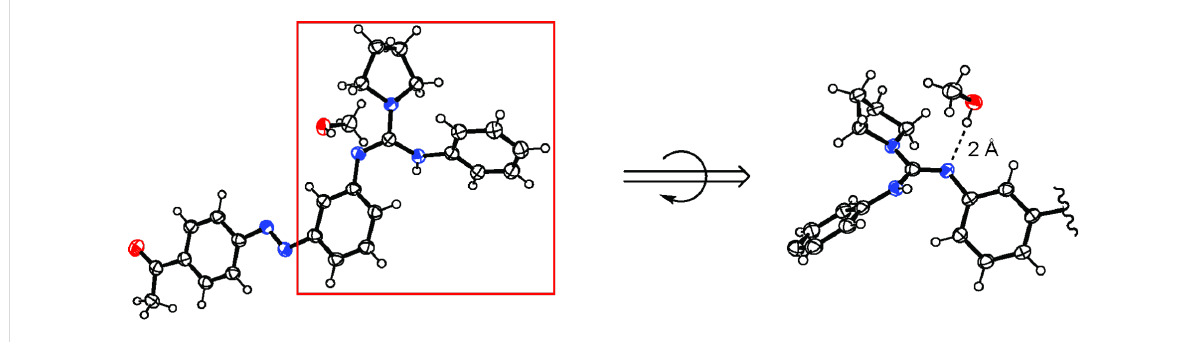
Figure 1: ORTEP image of the single-crystal X-ray structure of guanidine 2 E , as well as a rotated close-up of the guanidine moiety, showing 50% thermal ellipsoids (CCDC 891016).